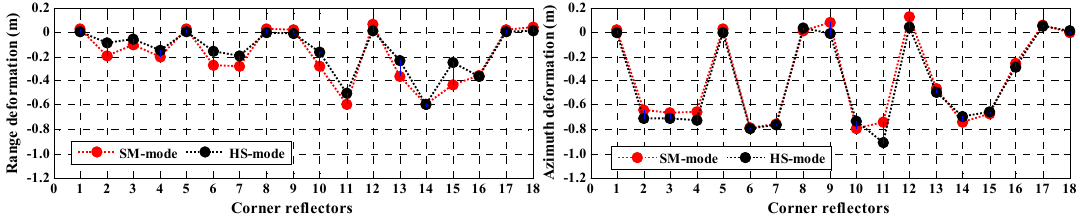
Table 2. Groups of 18 corner reflectors. Figure 8. Displacements of CRs at Shuping landslide in range ( left ) and azimuth ( right ) during February 2009 to April 2010. The black dot represents the SM-mode measurements, and the red dot represents the HS-mode measurements.